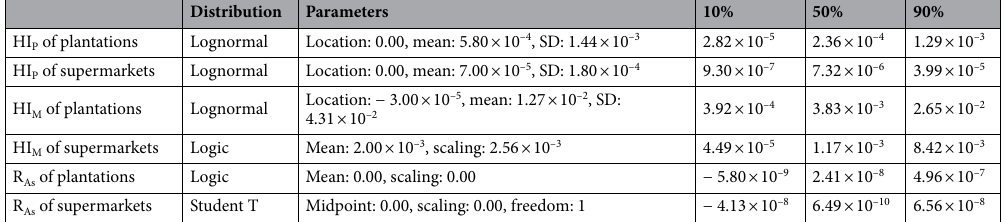
Table 4. Statistics of the probabilistic estimation of the hazard index (HI) and